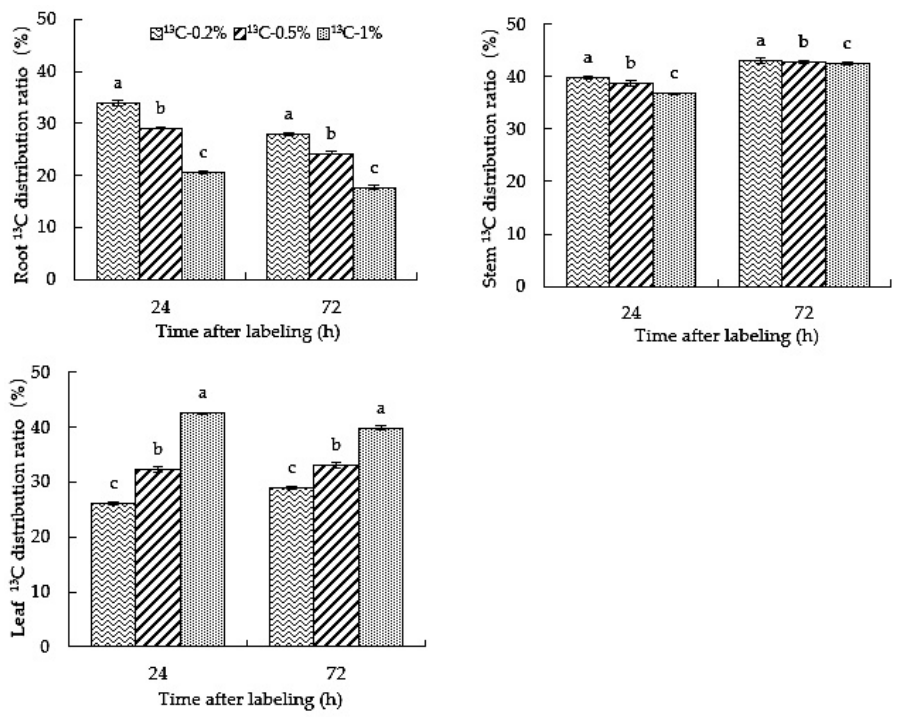
Figure 4. High root-zone 13 CO 2 affects the distribution proportion of carbon in roots, stems and leaves. Standard errors (SEs) of the means are represented by error bars. Different letters in the same row indicate significance at the 0.05 level among treatments.